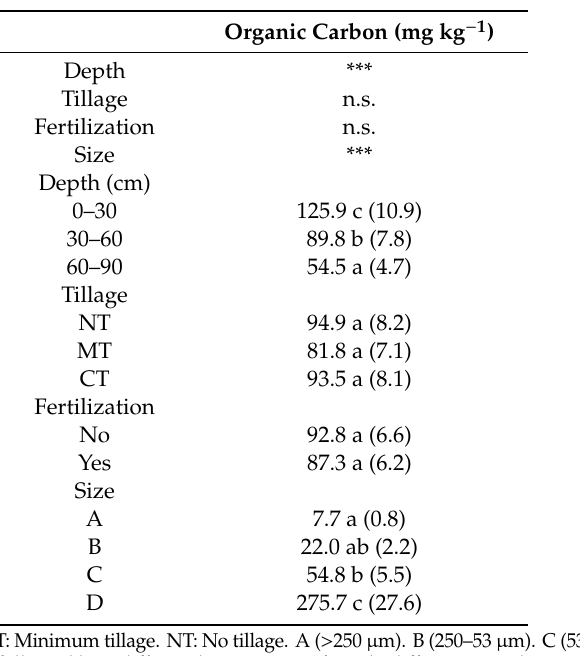
Table 3. Analysis of variance and mean values of the OC in soil fractions, subdivided by soil depth, tillage, fertilization treatment, and size of fractions. The standard deviation is in